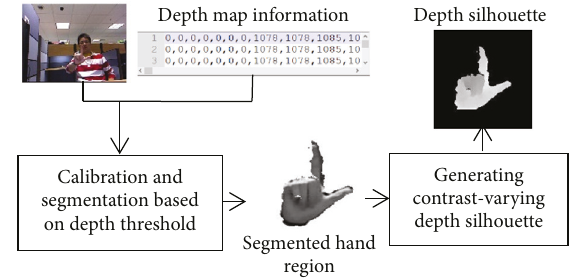
Figure 3: Hand gesture segmentation.